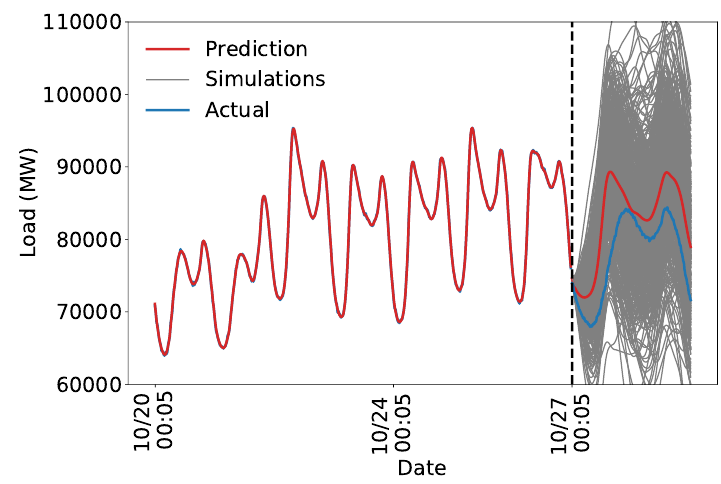
Figure 9. Backcasted and forecasted load using a composite kernel with a decay away from strict daily and weekly periodicity. Dashed vertical line signifies the transition from training data to test